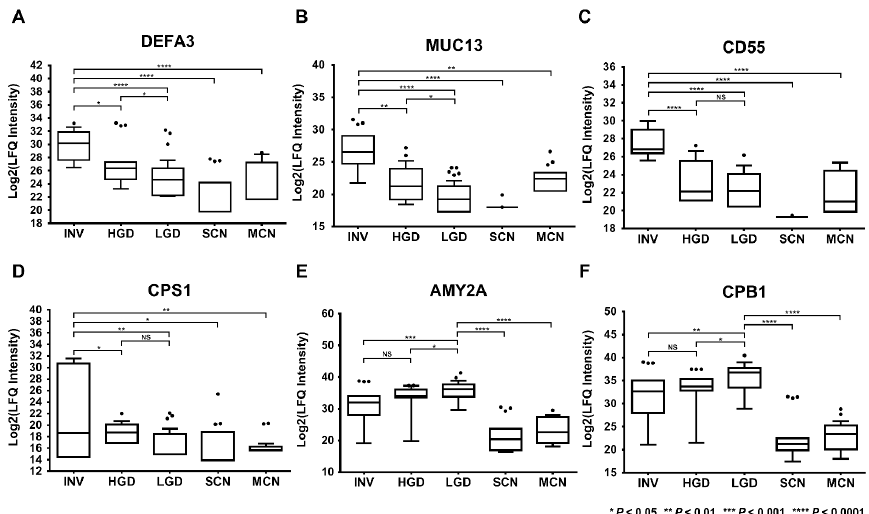
Figure 5. Six of the 19 potential markers that were differentially expressed in accordance with the degree of IPMN malignancy. DEFA3 ( A ), MUC13 ( B ), CD55 ( C ), CPS1 ( D ), AMY2A ( E ), and CPB1 ( F ) were differentially expressed, in accordance with the histological grades of IPMN. *, p < 0.05; **, p < 0.01; ***, p < 0.001; ****, p < 0.0001; NS, not available. Table S6 details the results of the statistical analysis of the 19 potential markers (7 upregulated proteins and 12 downregulated proteins), including statistical significance, p-values, and fold- changes for each comparative group. A total of 16 proteins, with the exception of RAB11B, KLK1, and CELA2A, were pancreatic tissue-specific proteins, according to the Human Protein Atlas. In addition, 15 proteins, with the exception of DEFA3, MUC13, RAB11B, and LEFTY1, were observed in plasma or serum, per the Plasma Proteome Database (PPD) (Table S1). The fold-changes of the 19 final marker candidates were assessed in relation to the general distribution of the 1019 proteins that were used for the statistical analysis. To this end, potential markers from comparisons 1 and 3 were displayed in a dynamic range and ordered, based on their fold-change. (Figure 6A,B). Excluding CD55, RAB11B, and CPS1 in comparison 1, 16 proteins had p- values below 0.05 and lay generally near the 2 extremes of the dynamic range. Similarly, in comparison 3, 19 candidates were statistically significant ( p < 0.05) and located near the upper and lower extremes of the dynamic range. All potential markers had higher fold-changes than CEA, the most well-established pancreatic cancer-associated marker.